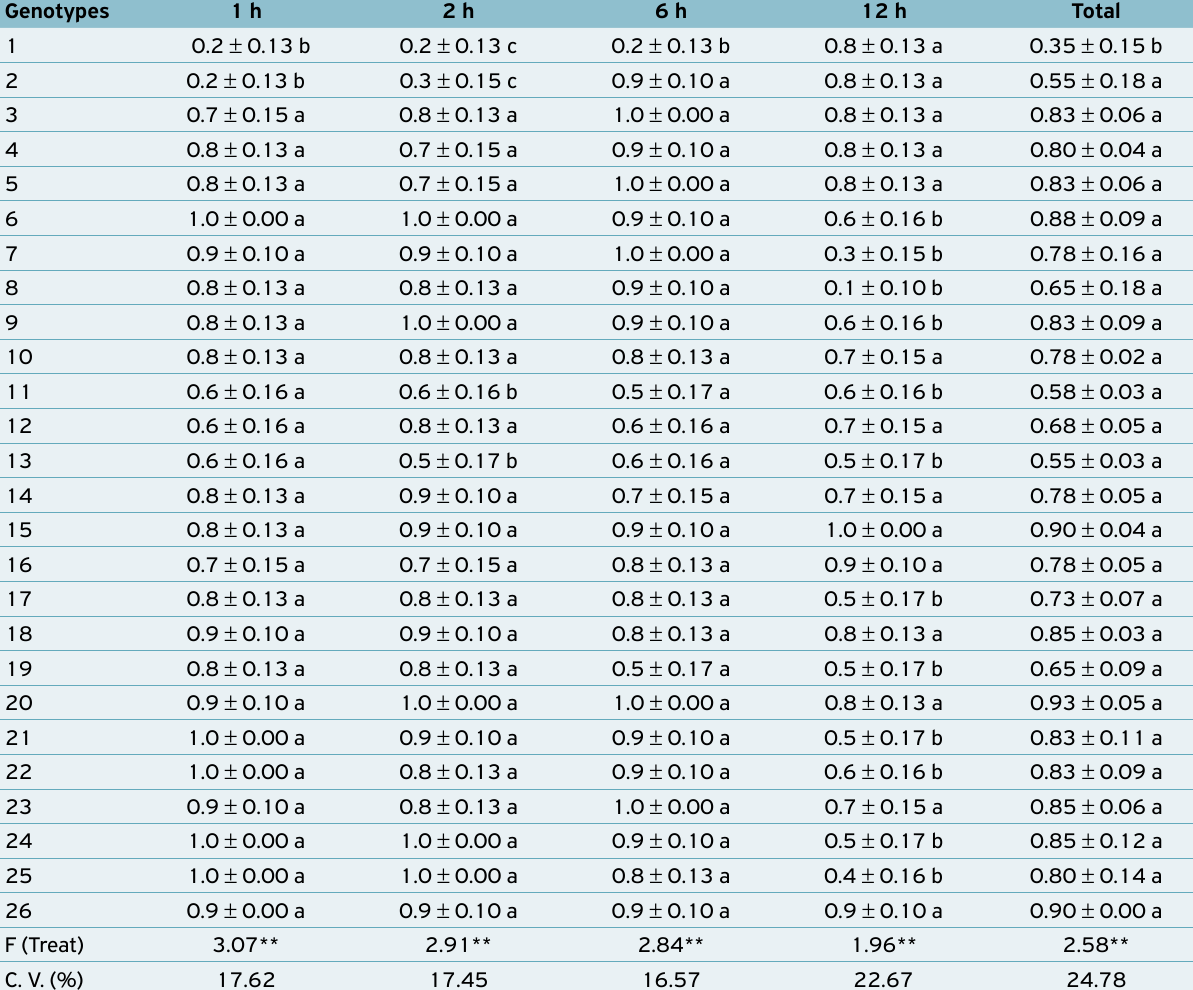
Table 2. Mean number ( ± SE) of third-instar larvae in non-choice test of Ascia monuste orseis in collard greens genotypes (temperature 25 ± 2ºC, relative humidity 70 ± 10% and photoperiod 12:12